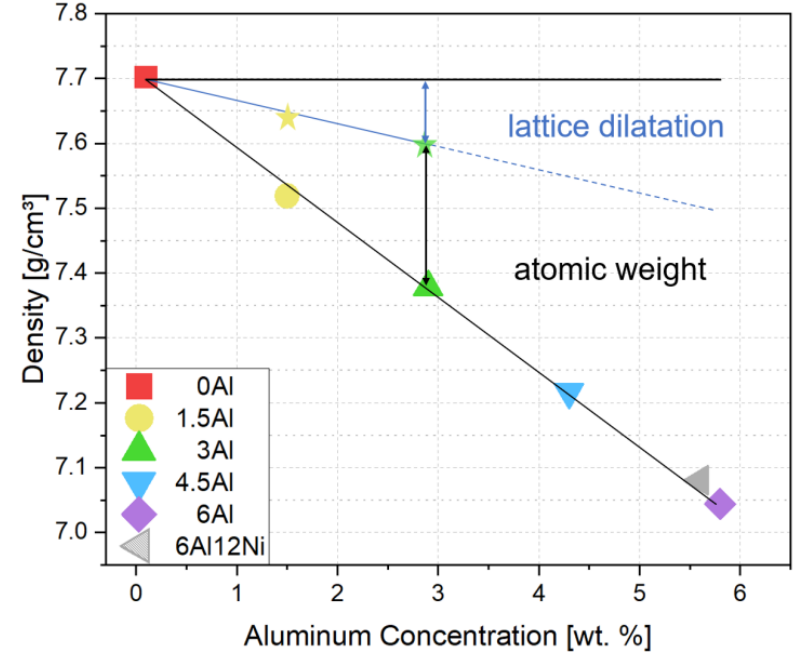
Figure 4. Density as a function of Al content. Hatched fill for the 6Al12Ni alloy is meant to emphasize its higher Ni content compared to the rest of the alloys. For the austenitic alloys, namely, alloys with up to 3 wt.% Al, the contributions of lattice dilatation and atomic weight to density reduction are separated by the solid line passing through star symbols. Star symbols indicate density on the mere basis of lattice parameter change with respect to the 0Al steel. The dashed line for duplex alloys indicates that the separation of contributions to density reduction was not based on actual lattice parameter measurements but extrapolated from the range of austenitic alloys.